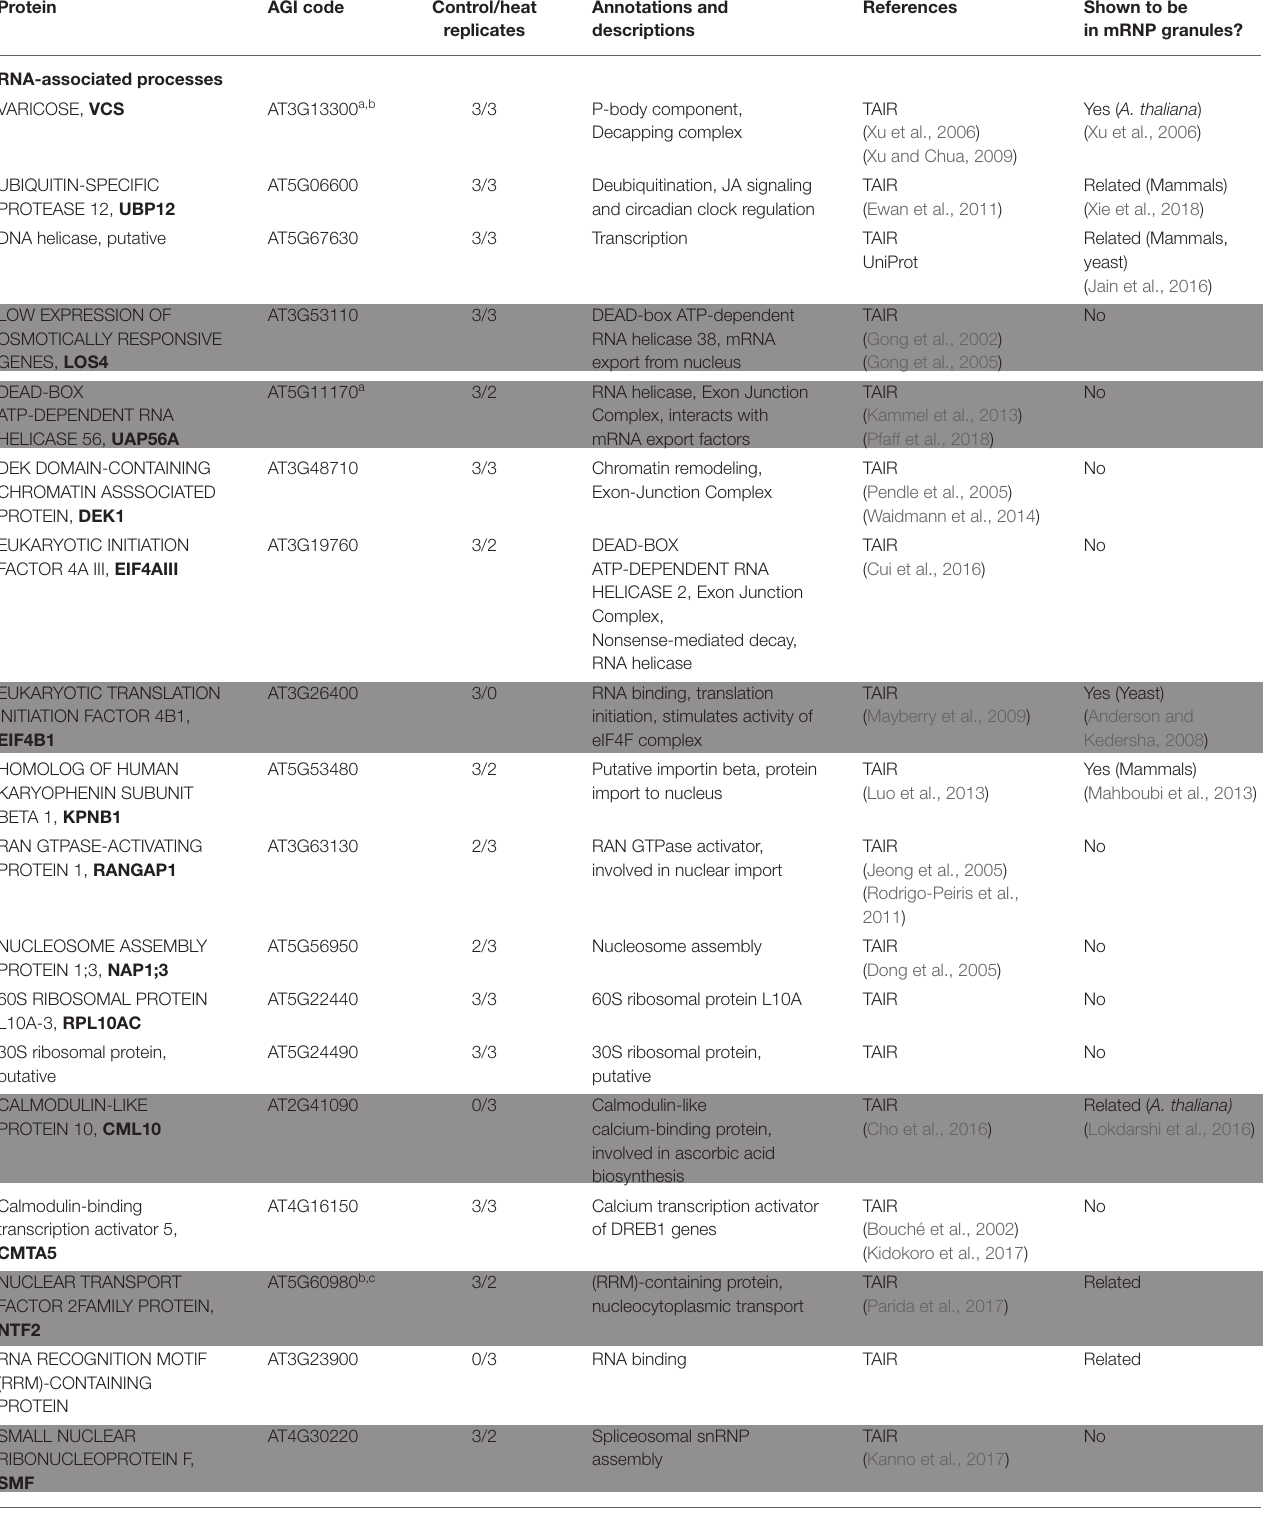
TABLE 1 | Proteins of the SKD1 interactome involved in RNA-associated processes.